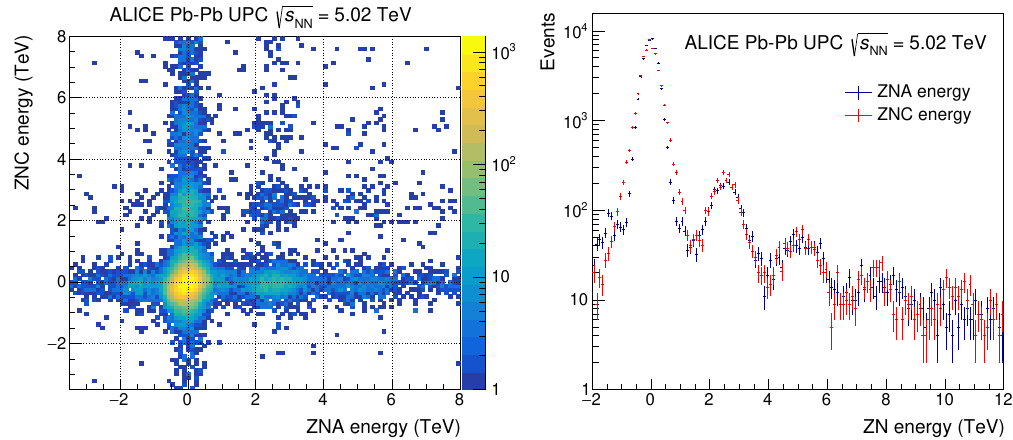
Figure 1 . (Colour online). Correlation between the energy distributions of the ZNA and ZNC detectors for events selected for the analysis (left). Energy distribution in each single detector